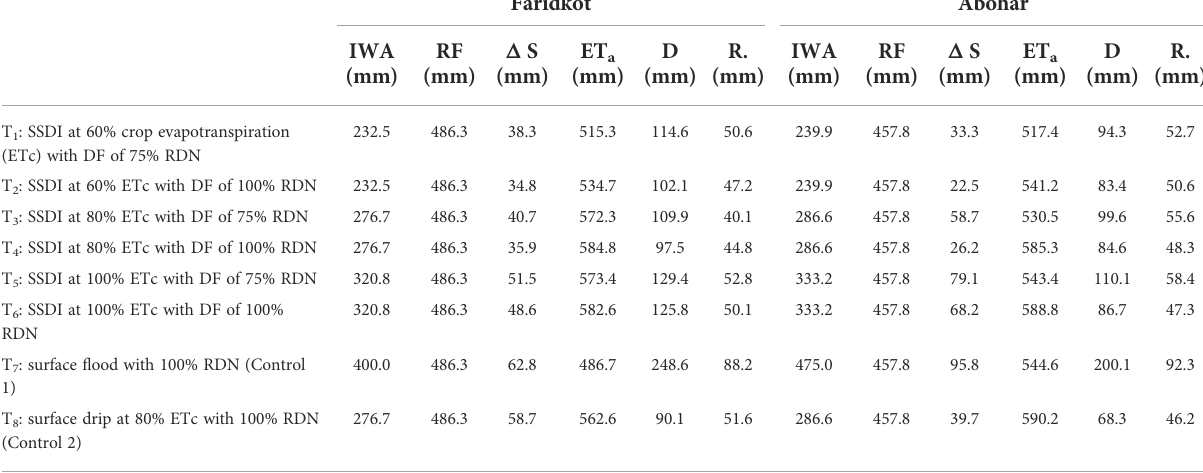
TABLE 6 Irrigation water applied and actual crop evapotranspiration under various treatments (2019). Faridkot